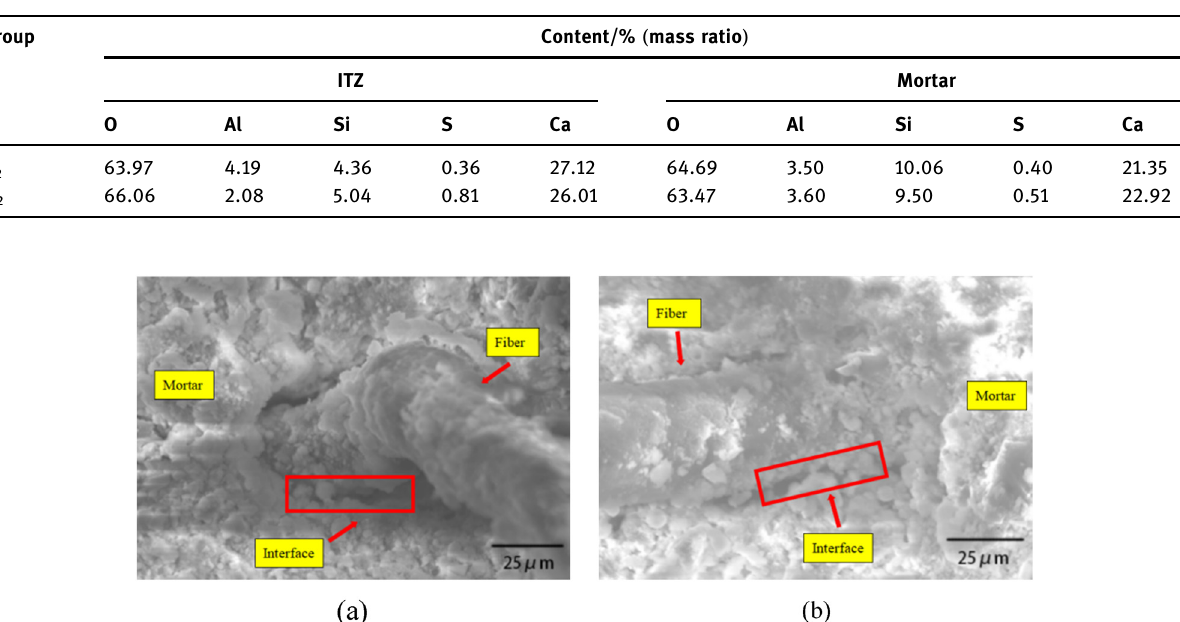
Table 8: Element composition from EDS analysis